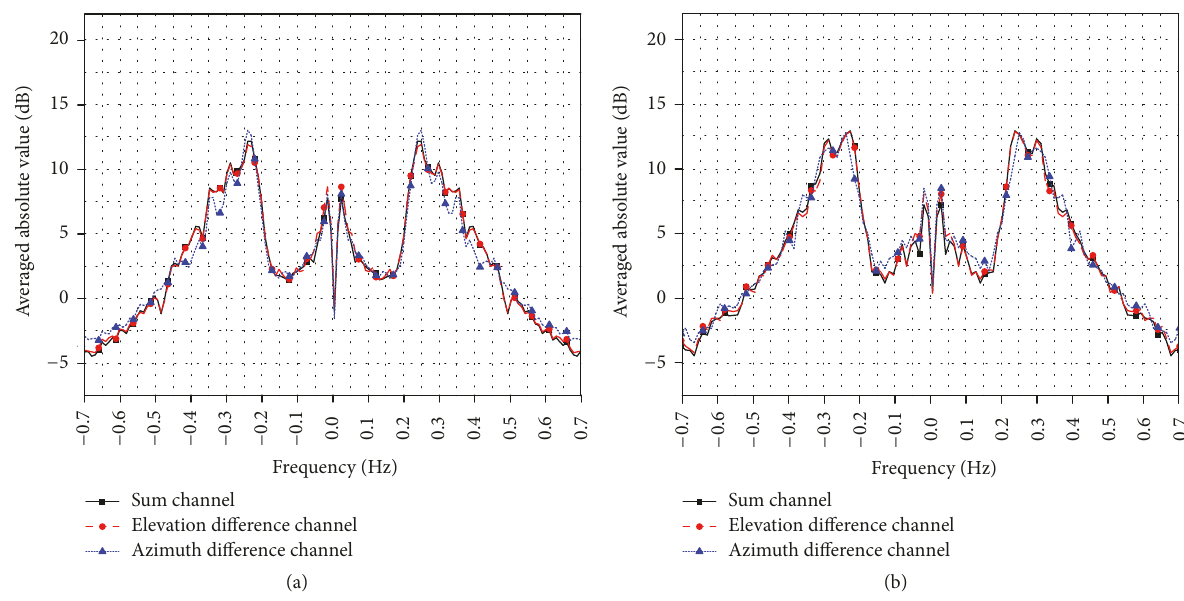
Figure 12: The averages of the power spectra of the temporal correlations of the texture for DS1 and DS2: (a) DS1. (b)